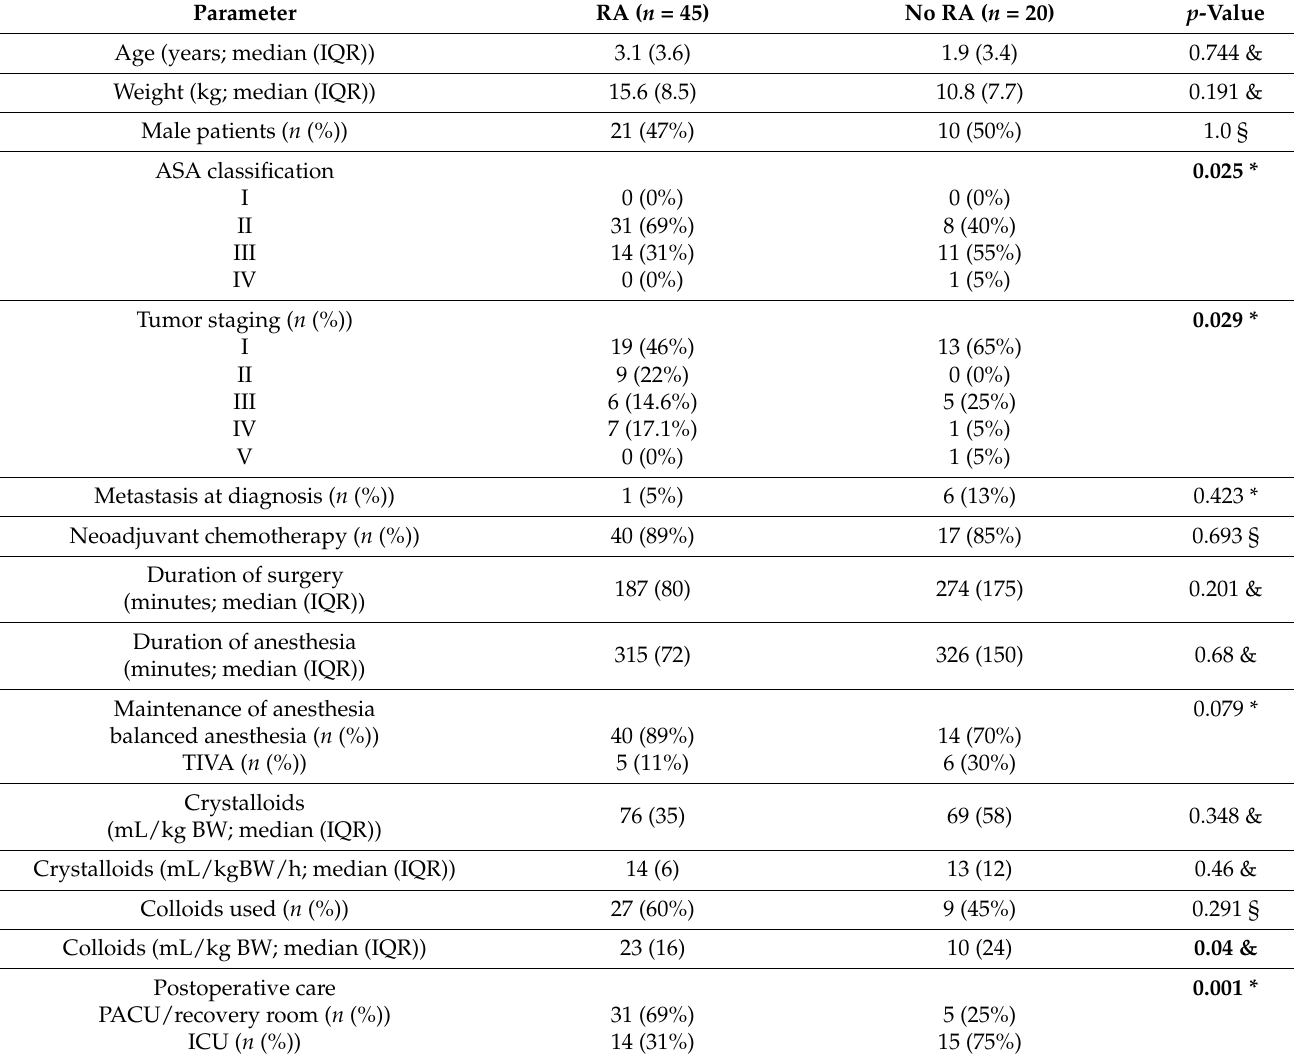
Table 3. Baseline patient characteristics and perioperative data: Regional anesthesia. RA = regional anesthesia, ASA = American Society of Anesthesiology; IQR = interquartile range; TIVA =